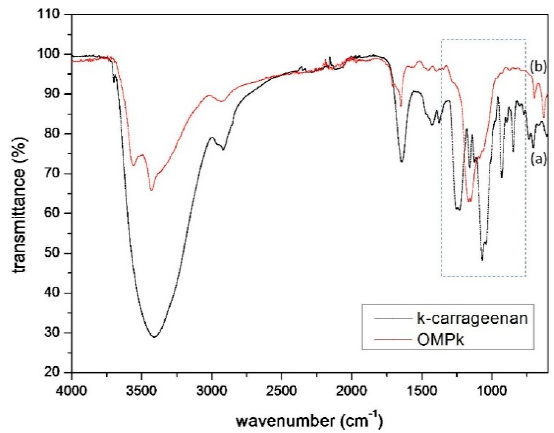
Figure 3. FTIR spectra of ( a ) κ -carrageenan and ( b ) O -methylene phosphonic κ -carrageenan (OMPk).